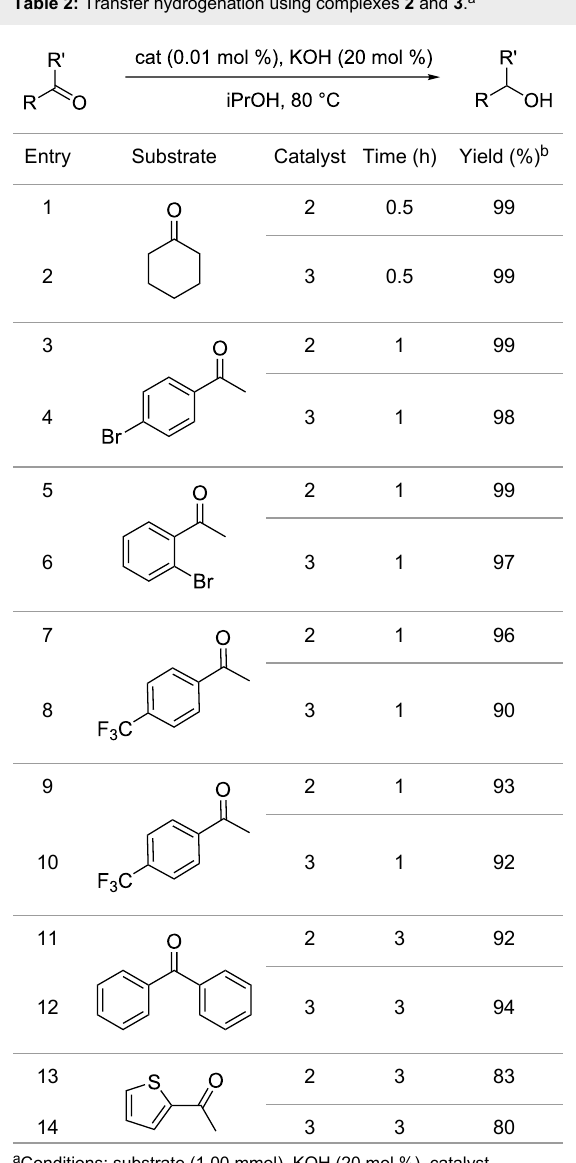
Table 2: Transfer hydrogenation using complexes 2 and 3 .